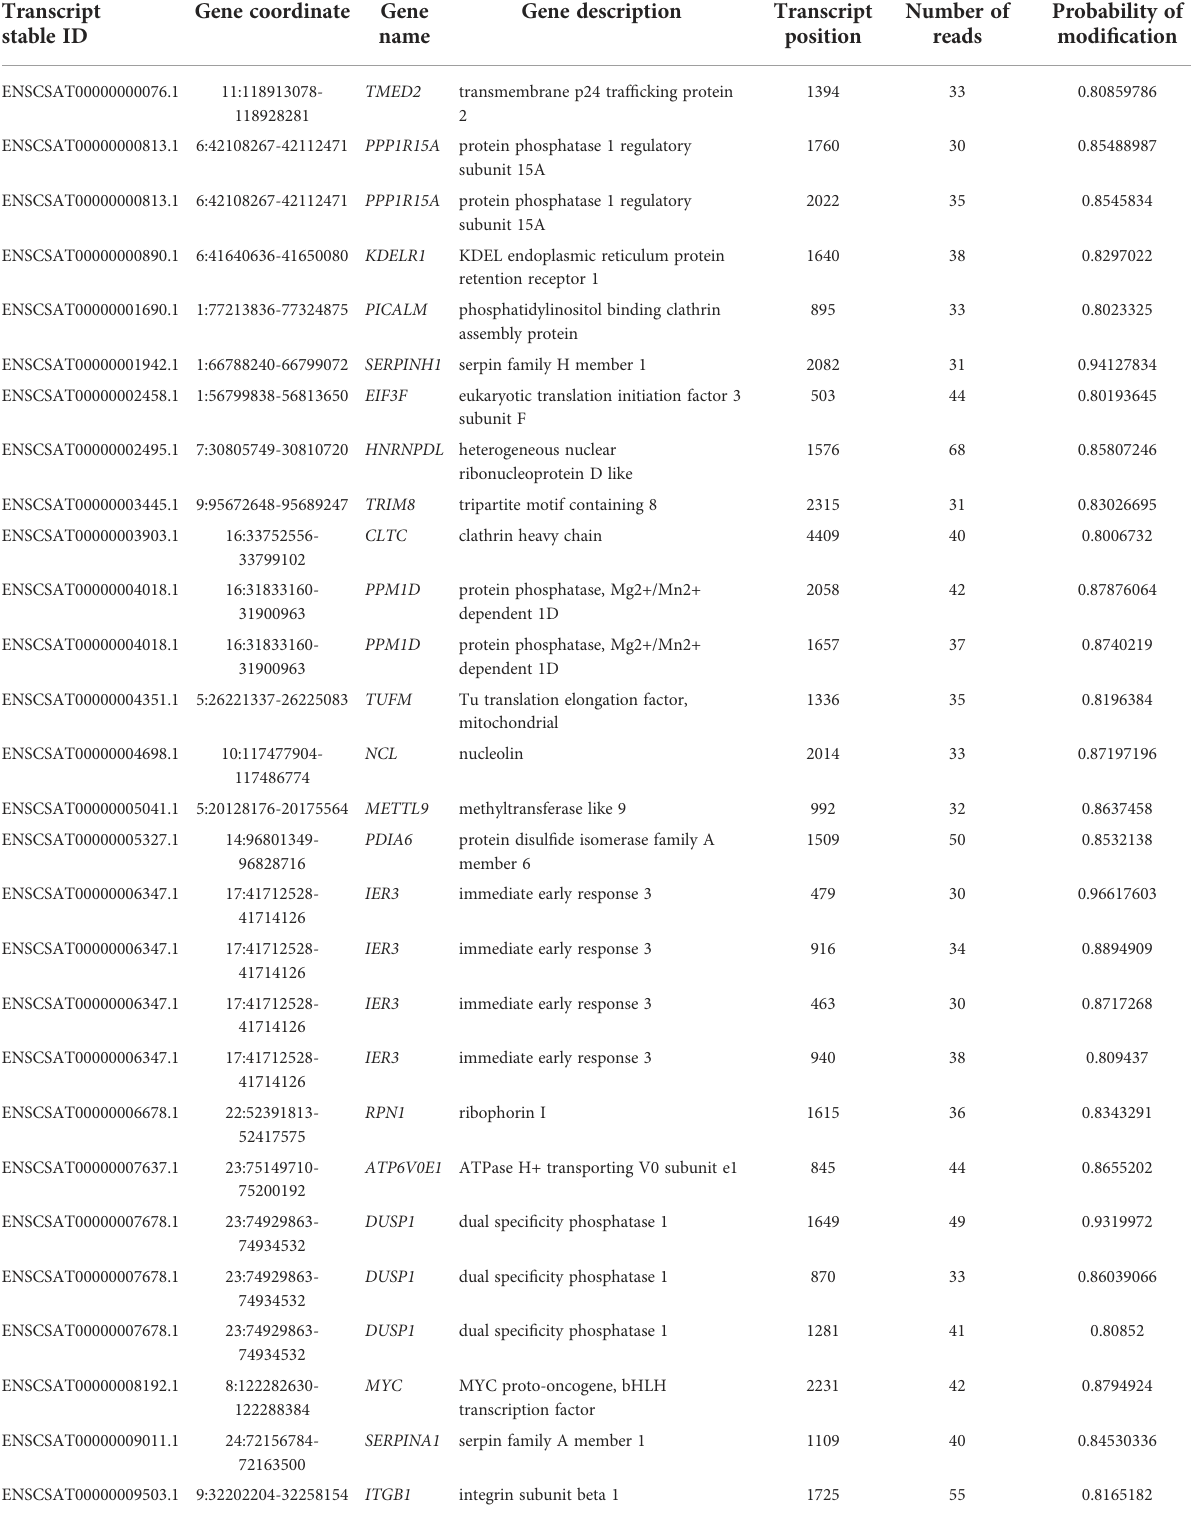
TABLE 4 Unique m6A sites in known genes of the infected sample – obtained by comparison of uninfected and infected cells dataset (Kim et al.,